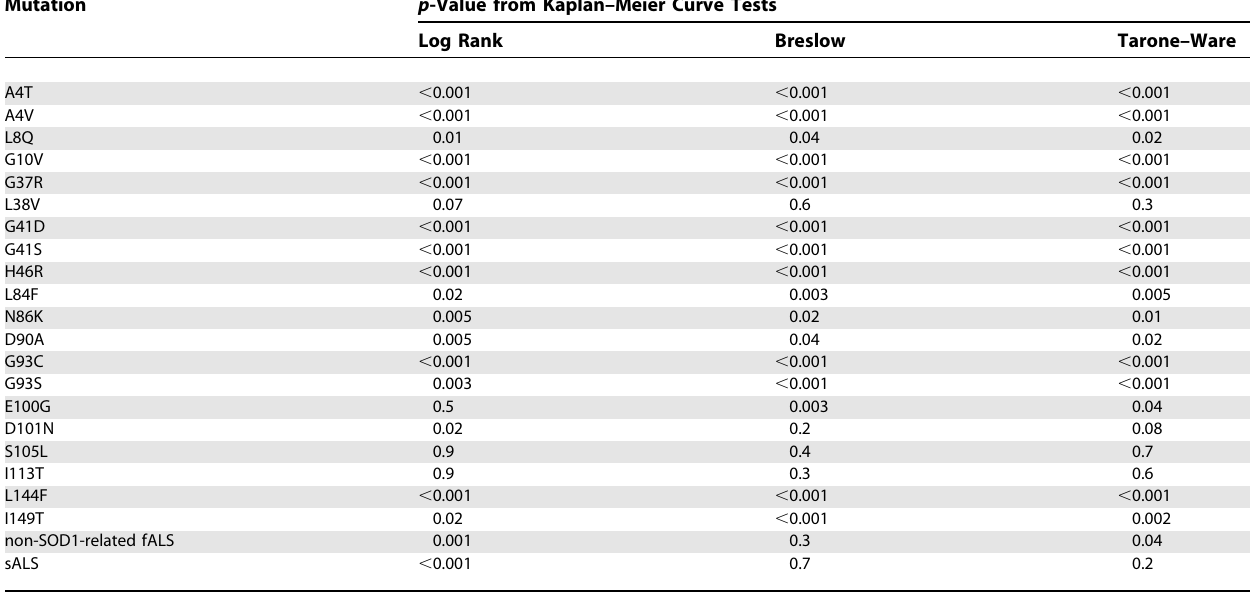
Table 2. SOD1 Mutations Are Inherently Related to ALS Patients’ Disease Duration Mutation p -Value from Kaplan–Meier Curve Tests Log Rank Breslow